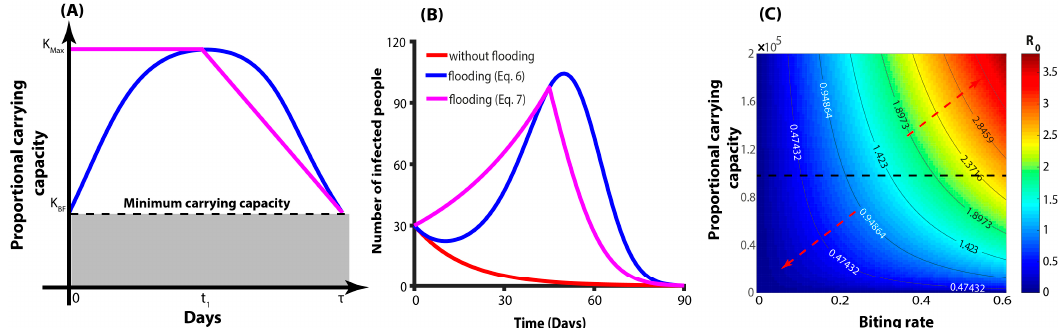
Figure 3. ( A ) Schematic representations of the form of the carrying capacity as a result of the flooding. The blue line denotes the carrying capacity form in Equation (6) and the pink line for Equation (7). ( B ) Predicted number of infected people under different scenarios. ( C ) Relationship between biting rate, carrying capacity and the basic reproduction number. The red arrows show the direction of increase and decrease of the R 0 . If people are more protected from bites then no endemic situation will be observed.